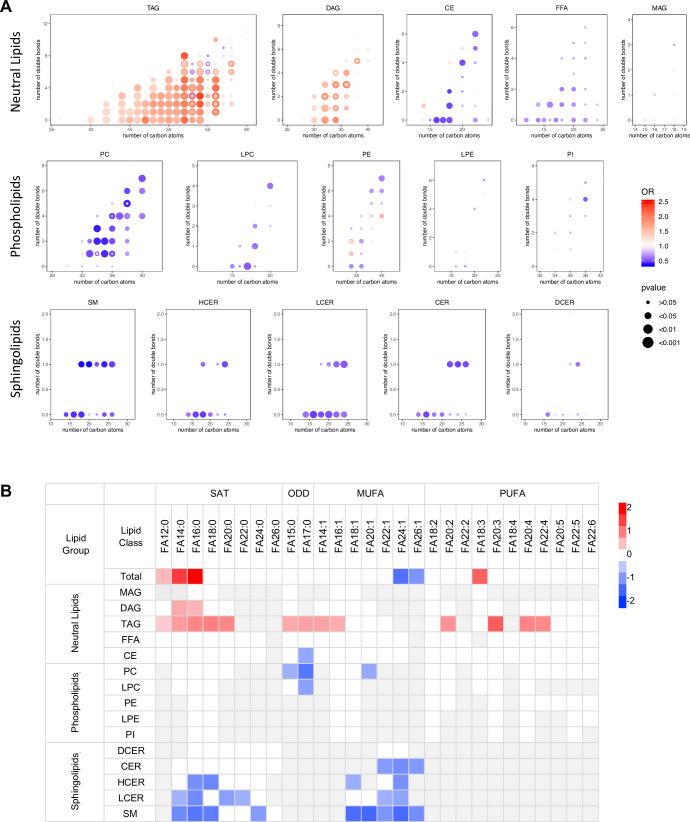
Association between diabetes risk and lipid structure.(A) Relationship between diabetes risk and total number of carbon atoms and double bonds in lipid species. Odds ratios were represented with dots, color denoting odds ratio value, dot size denoting significance by FDR value. (B) Relationship between diabetes risk and fatty acid composition in lipids. Red and blue color denotes log2(odds ratio) with significance (FDR < 0.05), white denotes values with no significance, grey denotes fatty acids not detected.Figure 4—source data 1.Odds ratio values, FDR values, numbers of carbon atoms and double bonds in all lipid species.Figure 4—source data 2.Relationship between diabetes risk and fatty acid composition in lipids.